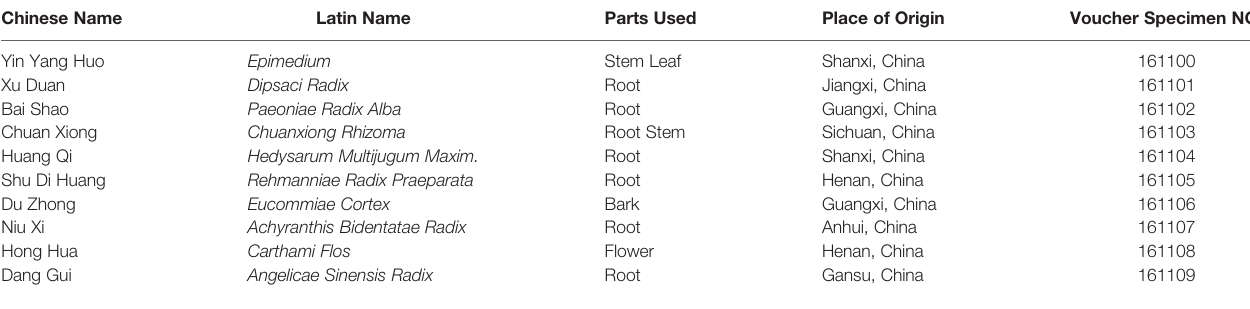
TABLE 1 | Detailed information of Zhuanggu Busui formula